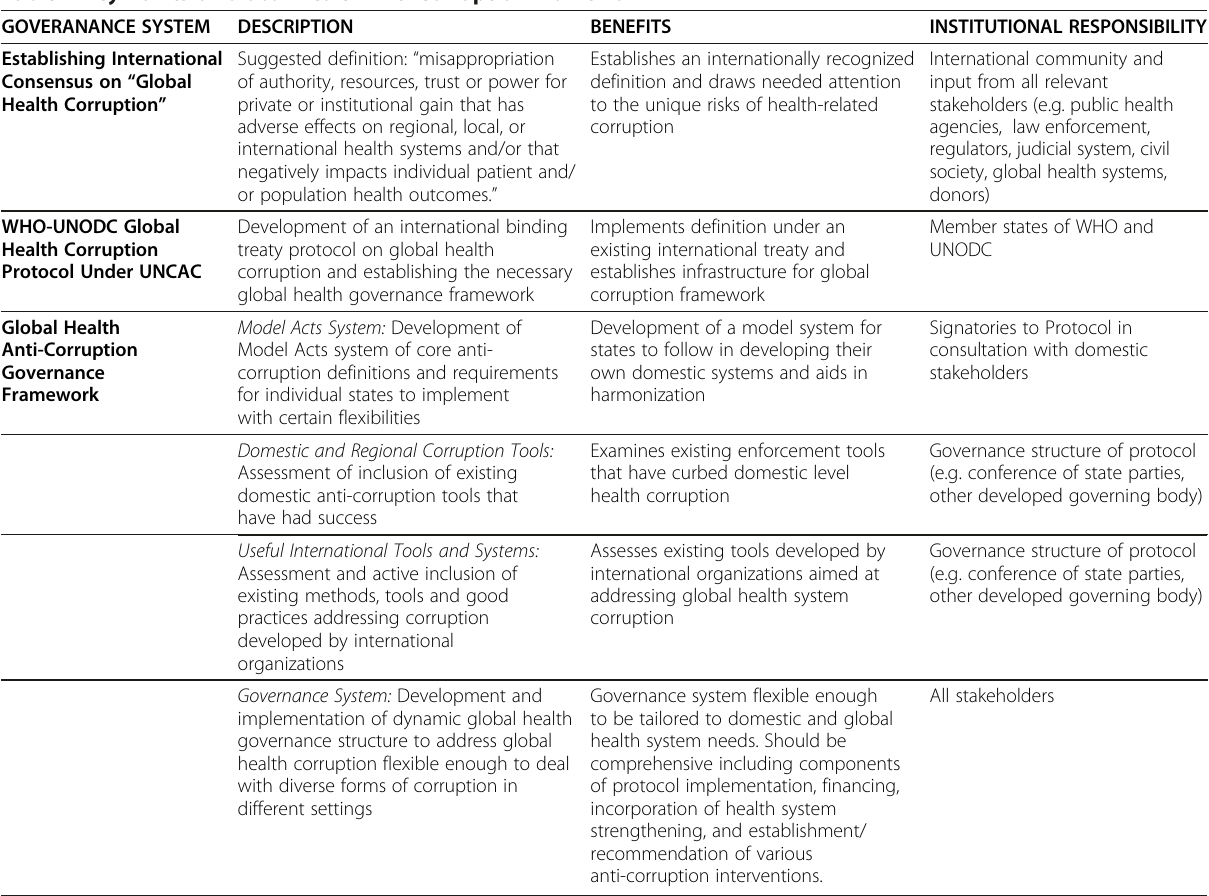
Table 1 Key Points of Global Health Anti-Corruption